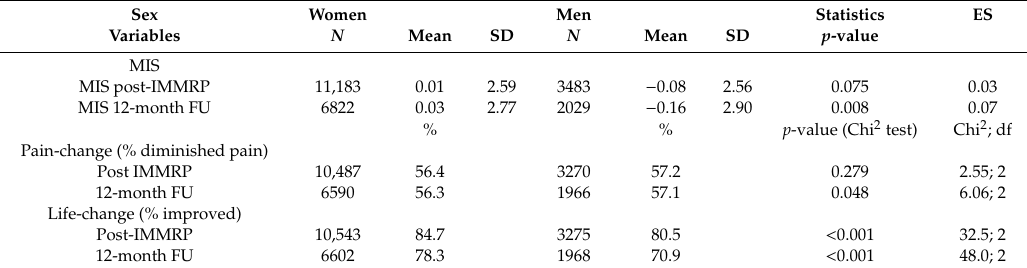
Table 2. Outcomes of interdisciplinary multimodal pain rehabilitation programs (IMMRPs) according to a multivariate improvement score (MIS) and change variables (change-pain and change-life) in women and men post-IMMRP and at 12-month follow up. Statistics are furthest to the right, i.e., group comparison ( t -test) together with e ff ect size (ES; Hedges’g) and Chi 2